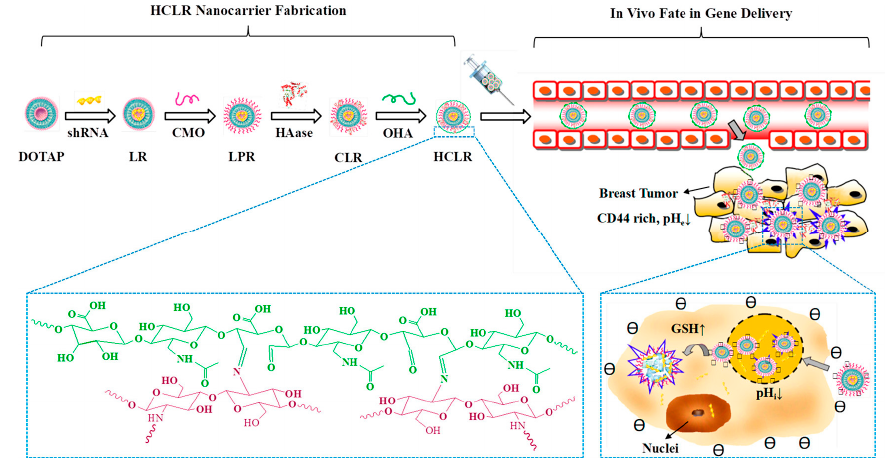
Figure 7. Schematic of HCLR nanocarrier fabrication and the in vivo fate in breast tumor targeting gene delivery. Taken from